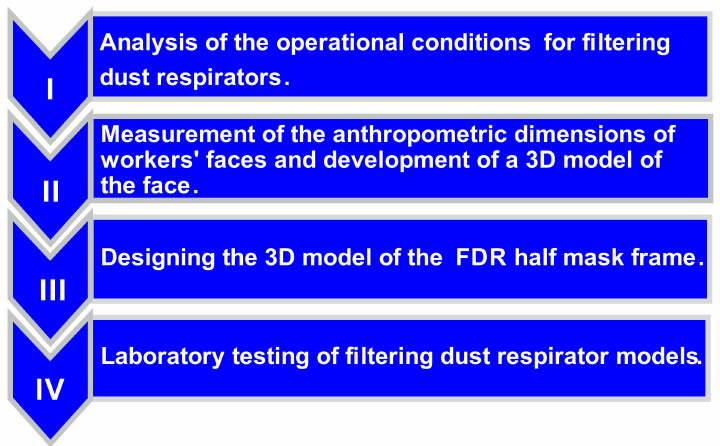
Figure 1. FDR design